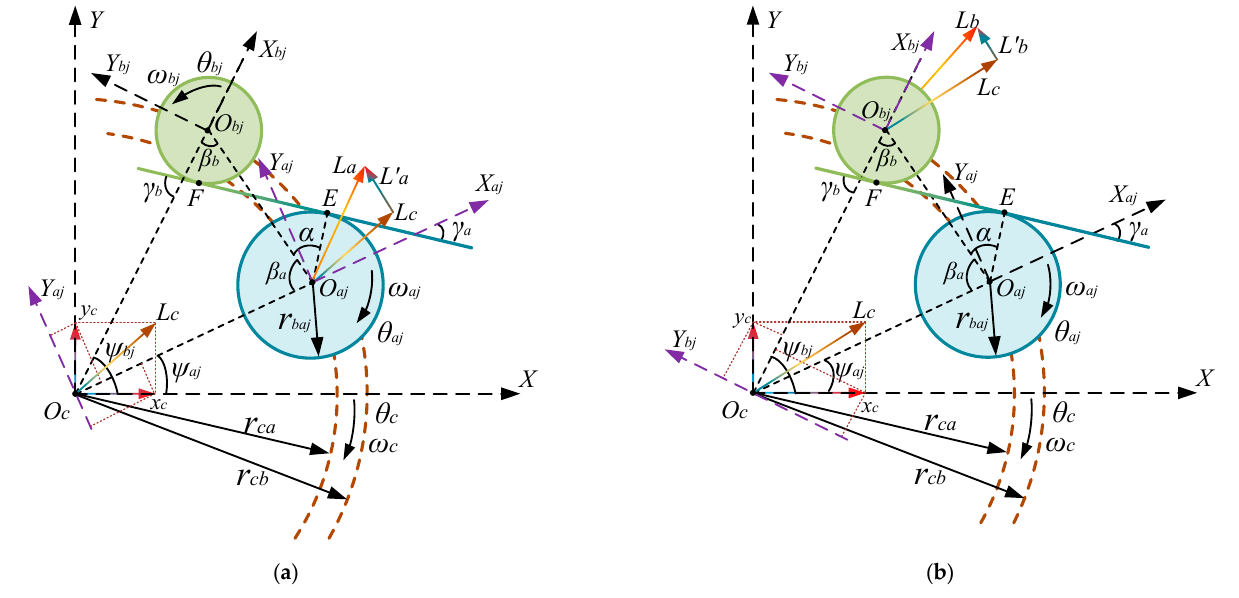
Figure 4. Translational meshing deformation relationship between the planetary gears a j and b j : ( a ) Projection relation of a j translation displacement; ( b ) Projection relation of b j translation displacement.